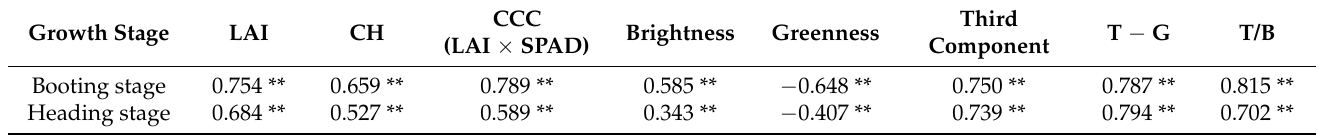
Table 3. Accuracy comparison of different regression models.